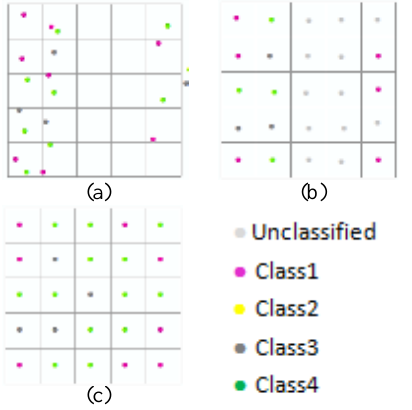
Figure 2: Example of assigning classes to the unclassified grid points using the Iterative Majority Moving Window (IMMW) method a) the classified original points and the defined grid space, b) the resampled points to the grid space, c) the classified grid points after applying the IMMW